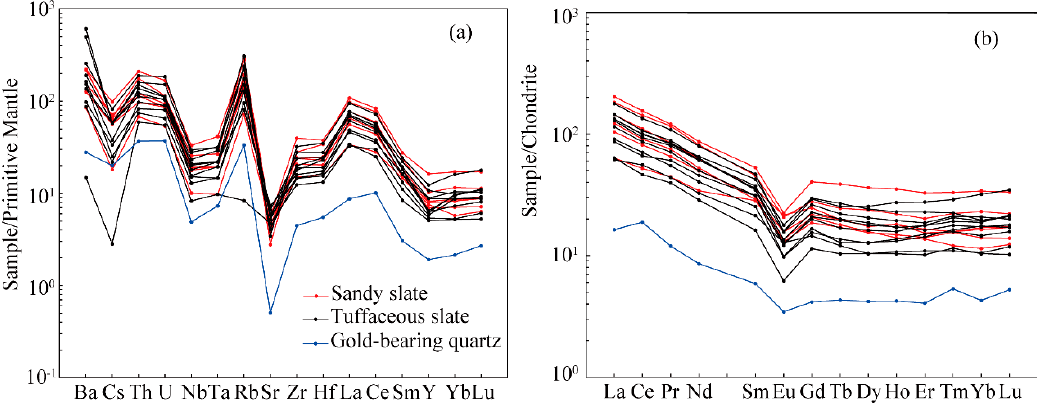
Figure 7. ( a ) Primitive mantle- and ( b ) chondrite-normalized patterns of samples from the Chaoyangzhai gold deposit. (a) and (b) are modified from [42,43], respectively.